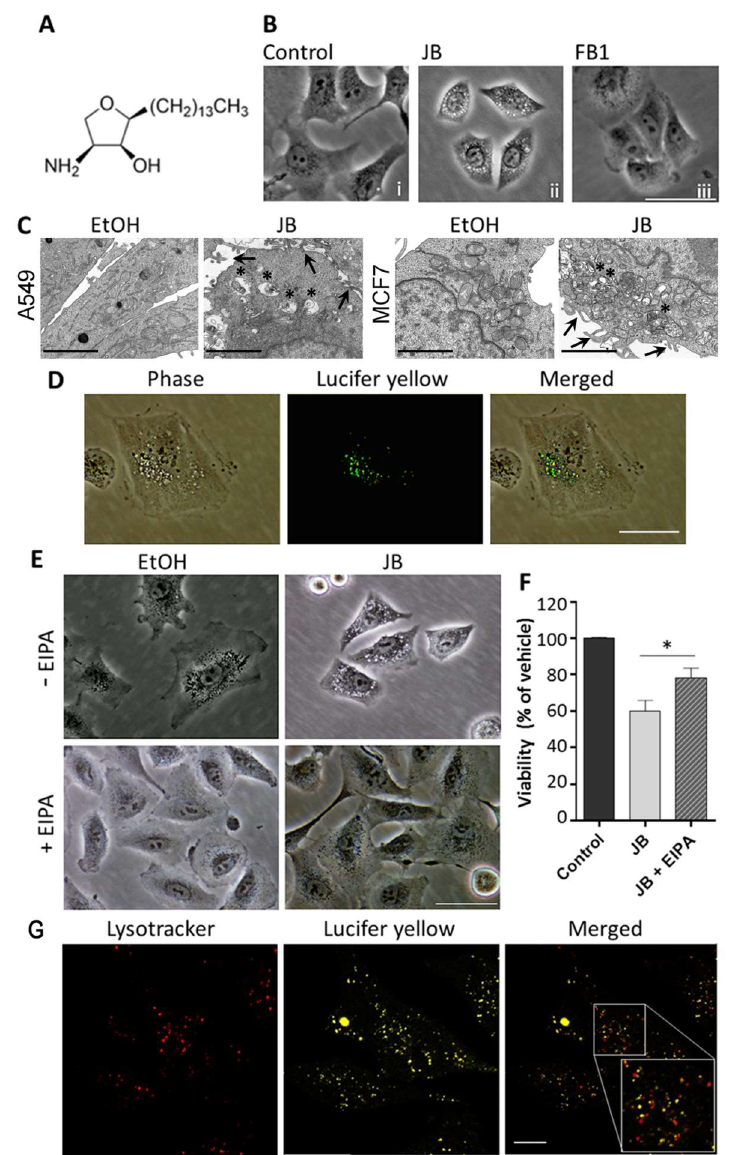
Figure 1. Induction of cell vacuolization by Jaspine B (JB) in A549 cells. ( A ) Chemical structure of JB. ( B ) Phase contrast images of A549 cells treated with 0.05% ethanol for 24 h, 5 µM JB for 4 h, or 50 µM Fumonisin B1 (FB1) for 24 h. The images are representative of three experiments performed in triplicate. Scale bar: 50 µm. ( C ) TEM images of A549 cells treated with 0.05% ethanol for 4 h or 10 µM JB for 5 h and MCF7-LC3GFP cells treated with 0.05% ethanol for 6 h or 10 µM JB for 6 h. Arrows point to membrane extensions at the surface of A549 or MCF7 cells and asterisks show endolysosome accumulation indicating defective endocytic flux. Scale bars: 2 µm . (D ) Incorporation of Lucifer yellow (LY) in A549 cells incubated with 5 µM JB and 0.5 mg/mL LY for 4 h. Scale bar: 50 µm. ( E ) Phase contrast images of A549 cells pretreated with 25 µM 5-[N-ethyl-N-isopropyl] amiloride (EIPA) (or methanol) for 1 h and then treated with 5 µM JB (or ethanol) for 24 h. The images are representative of two independent experiments performed in triplicate. Scale bar: 50 µm. ( F ) Viability of A549 cells pretreated with 25 µM EIPA (or methanol) for 1 h and then treated with 5 µM JB (or ethanol) for 24 h, as assessed with 3-(4,5-dimethylthiazol-2-yl)-2,5-diphenyl tetrazolium bromide (MTT). Control cells were treated with vehicles (without EIPA and without JB). Results are the mean ± SD of two experiments in triplicate. * p < 0.0005. ( G ) A549 cells were treated with 5 µ M JB and 0.5 mg/mL LY for 4 h. An amount of 75 nM LT was added 0.5 h prior to visualization. Scale bar: 10 µ